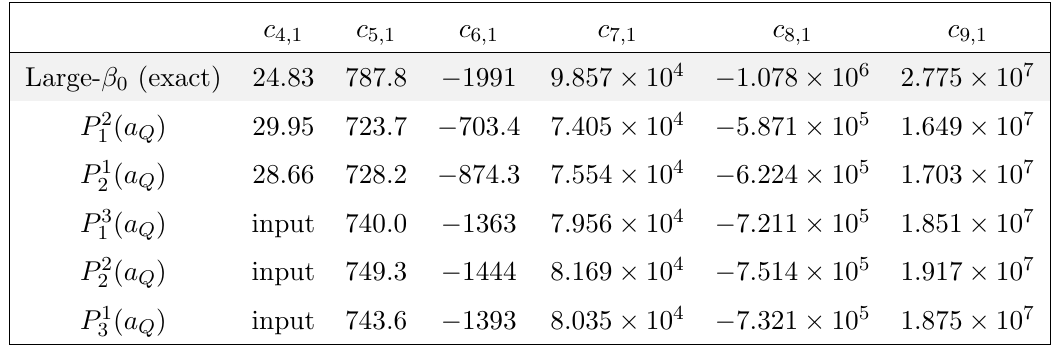
Table 2. Adler function coe(cid:14)cients extracted from PAs P N (cid:14) (0) in the large- (cid:12) 0